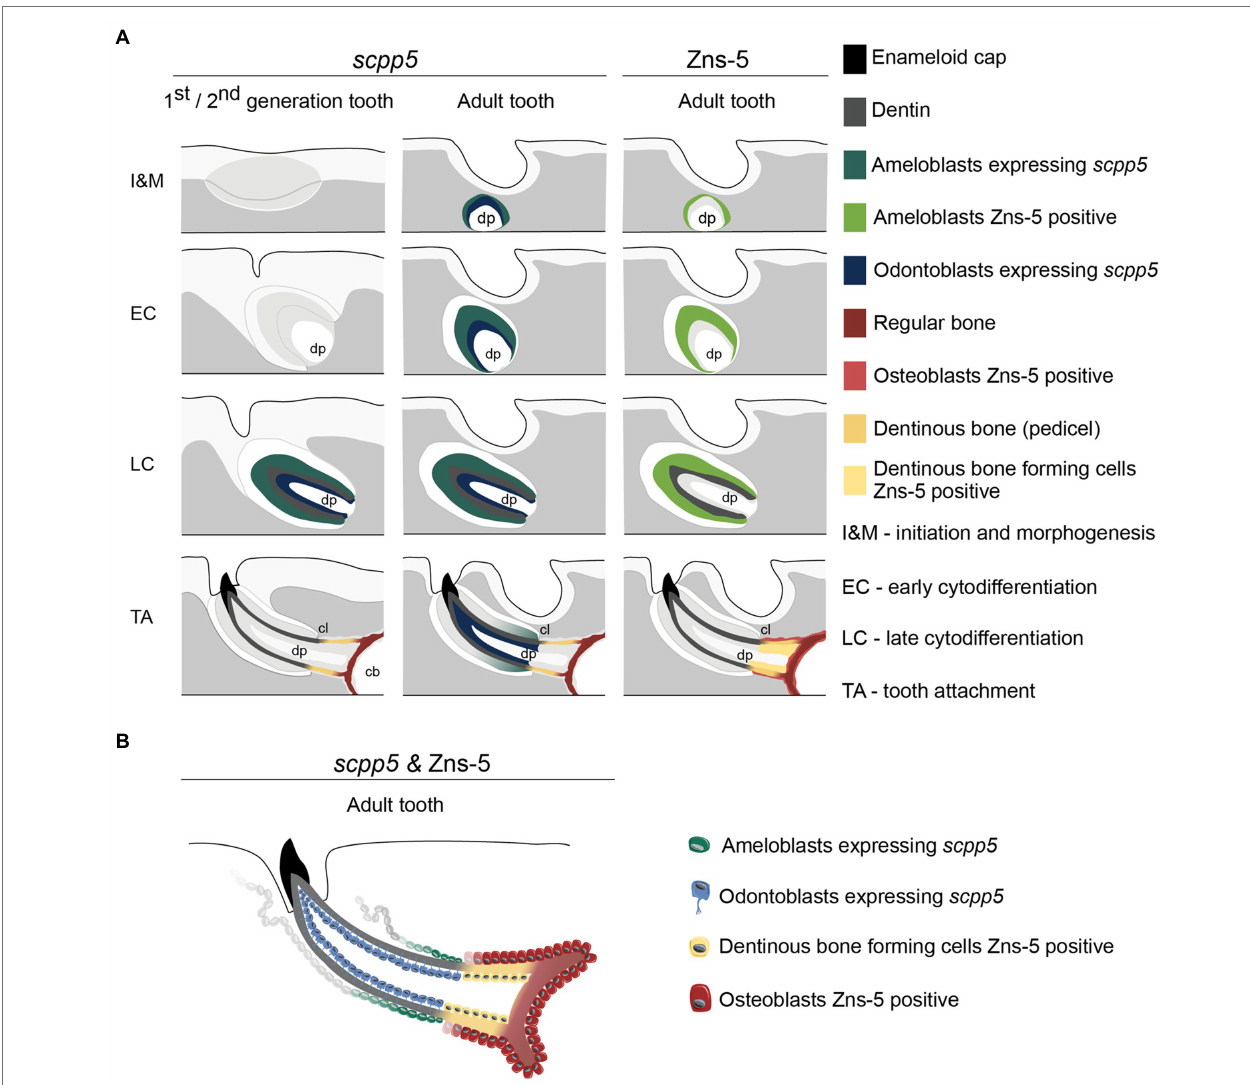
FIGURE 4 | Interpretative scheme showing localization of scpp5 transcripts and Zns-5 detection during zebrafish tooth development. Panel (A) shows a representation of scpp5 expression during first and second generation and adult tooth formation, from the stage of initiation and morphogenesis to tooth attachment, and of Zns-5 detection in adult teeth, at the same developmental stages. Panel (B) shows the comparison between the expression of scpp5 and the localization of Zns-5, the former being exclusively expressed by ameloblasts and odontoblasts and the latter by cells forming the pedicel and by osteoblasts. In both panels, the adult tooth is depicted in a similar way as the first/second-generation teeth, although the tooth is larger, with thicker walls, and is attached to bone with all cartilage having been resorbed in this area. cb, ceratobranchial cartilage; cl, cervical loop; and dp, dental